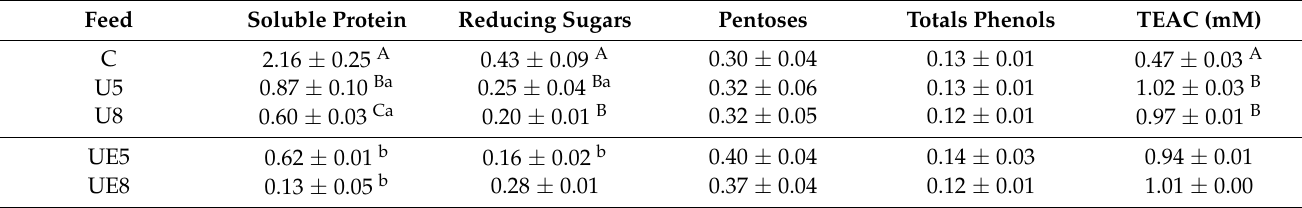
Table 3. Experiment 2. Nutrient content of the feeds expressed in g/100 d.m. Values are presented as mean ± SD. Values in columns not sharing the same letter differ significantly with p < 0.05. Comparisons between inclusion levels (0%, 5%, 8%) are indicated with capital letters, while paired comparisons between enzyme treatment (U5/UE5; U8/UE8) are indicated with lowercase letters.